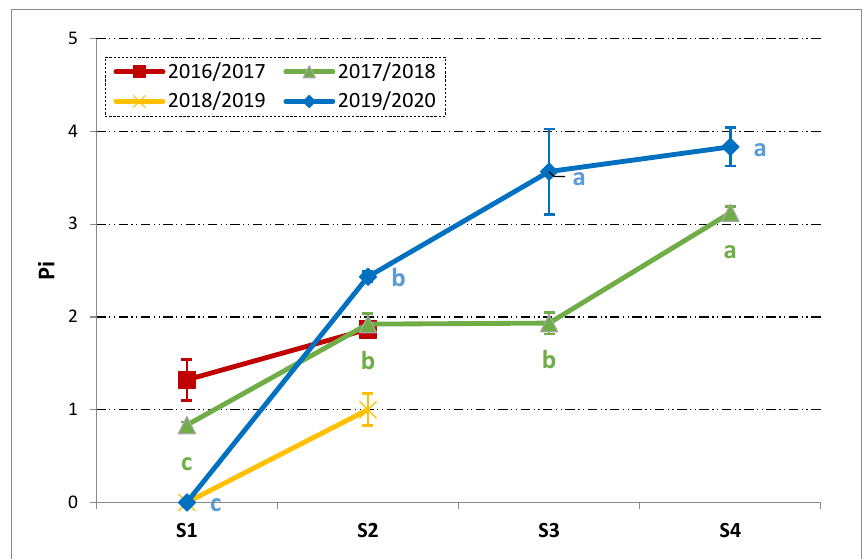
Figure 1. Trends in the Pi (mean ± SD, n = 3) of the Oliva Rossa drupes during ripening in four consecutive harvest seasons. Different letters for each harvest year indicate significant differences according to one-way ANOVA followed by Fisher’s LSD post-hoc test (α = 0.05). S1–S4: four subsequent samplings.